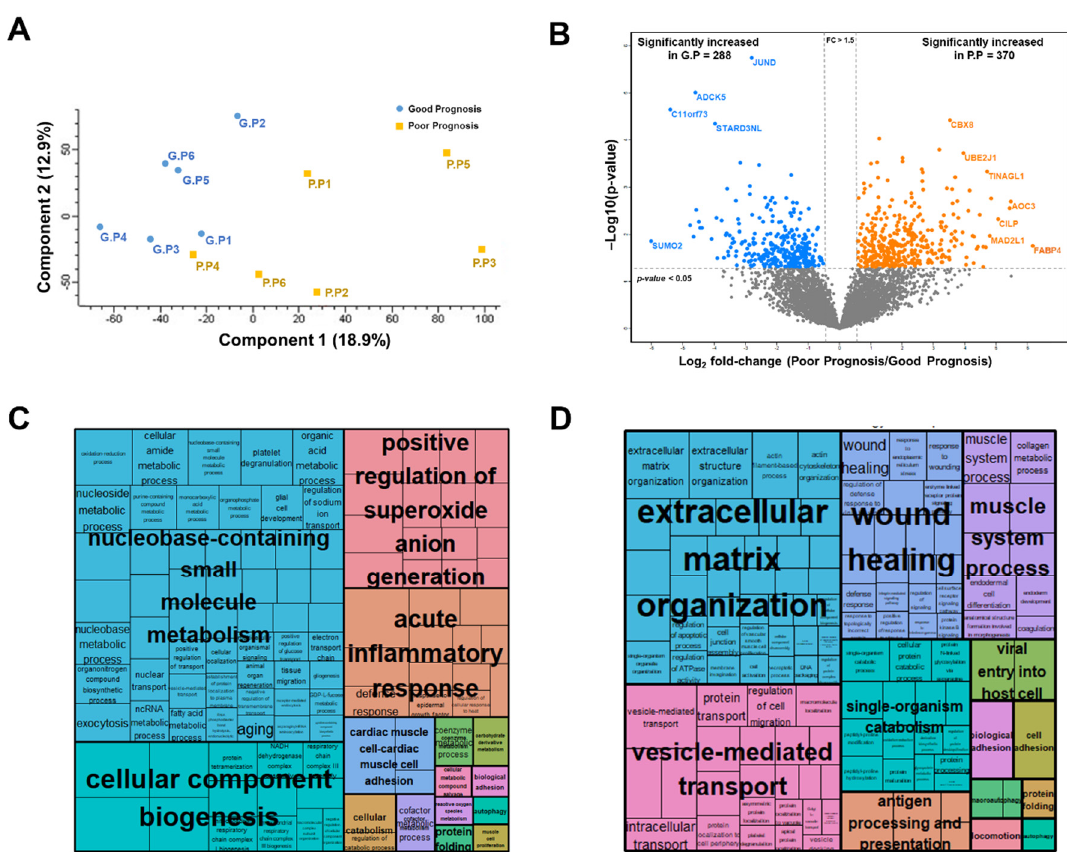
Figure 2. Statistical and functional differences between good and poor prognosis groups: ( A ) principal component analysis (PCA); ( B ) volcano plot; ( C ) gene ontology biological process (GOBP) enrichment tree-map of upregulated proteins in the good prognosis group; ( D ) GOBP enrichment tree-map of upregulated proteins in the poor prognosis group.